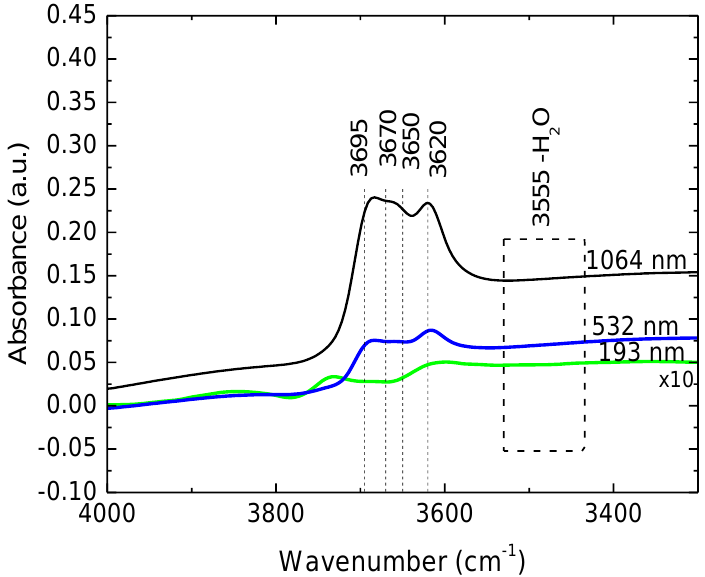
Figure 10. DRIFT spectra of the hydroxyl stretching region of the films deposited via PLD at 193 nm, 532 nm and 1064 nm.